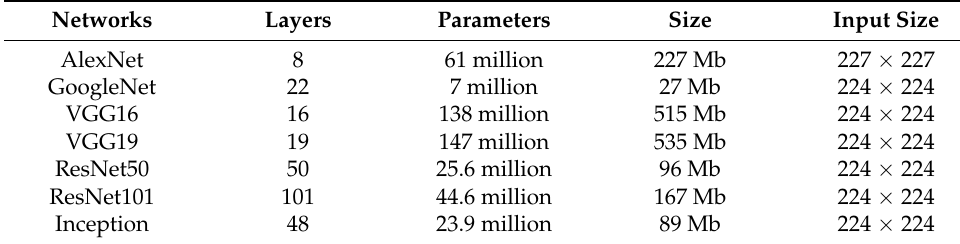
Table 1. Specifications of the different network